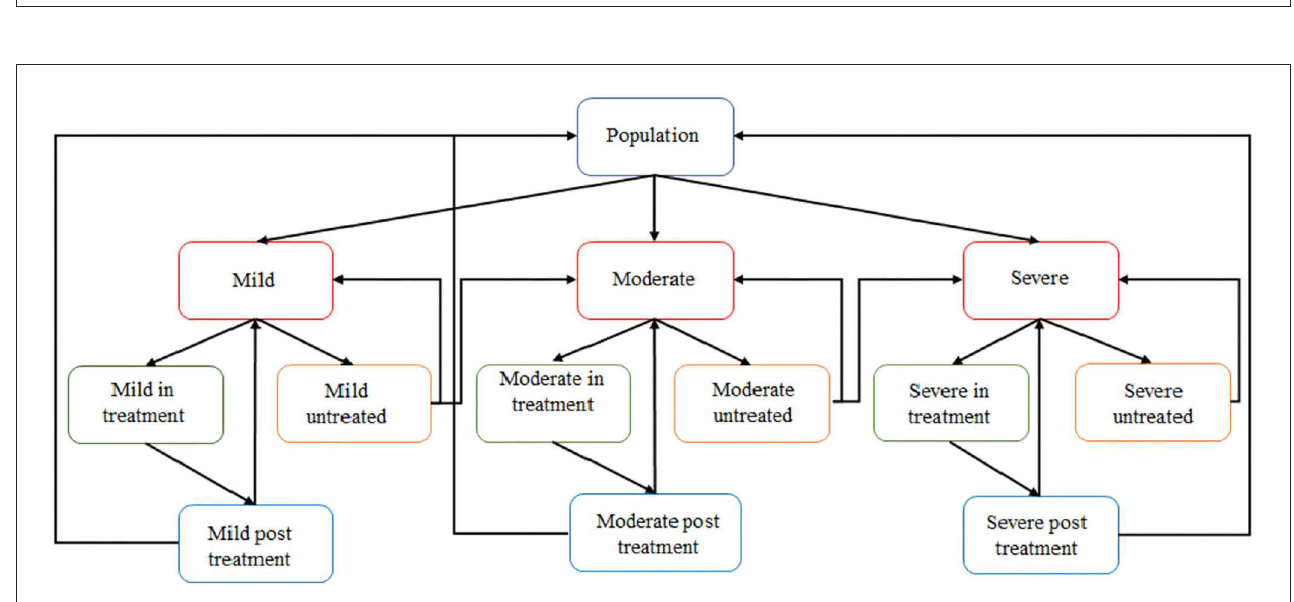
FIGURE2 Illustration of multi-agent depression model built in AnyLogic.